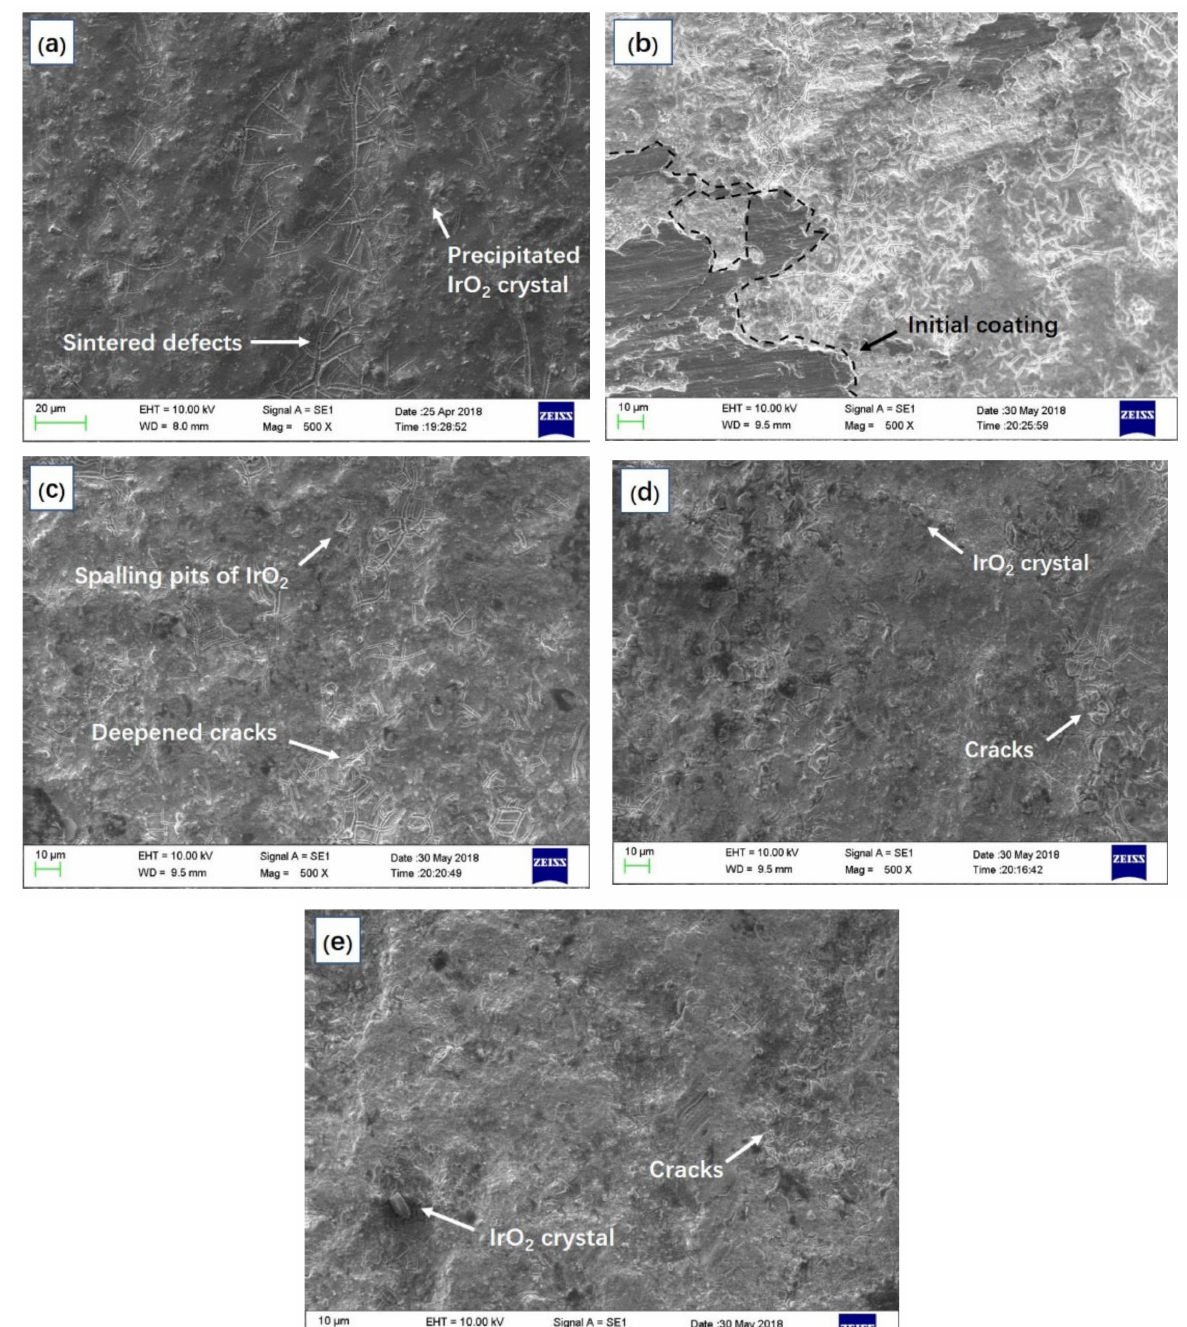
Figure 5. The SEM images of the primary anode surface after the simulated ICCP test: ( a ) raw anode metal, ( b ) anode metal from the cell with NA, ( c ) anode metal from the cell with 15 vol% of LFA, ( d ) anode metal from the cell with 25 vol% of LFA, and ( e ) anode metal from the cell with 40 vol% of